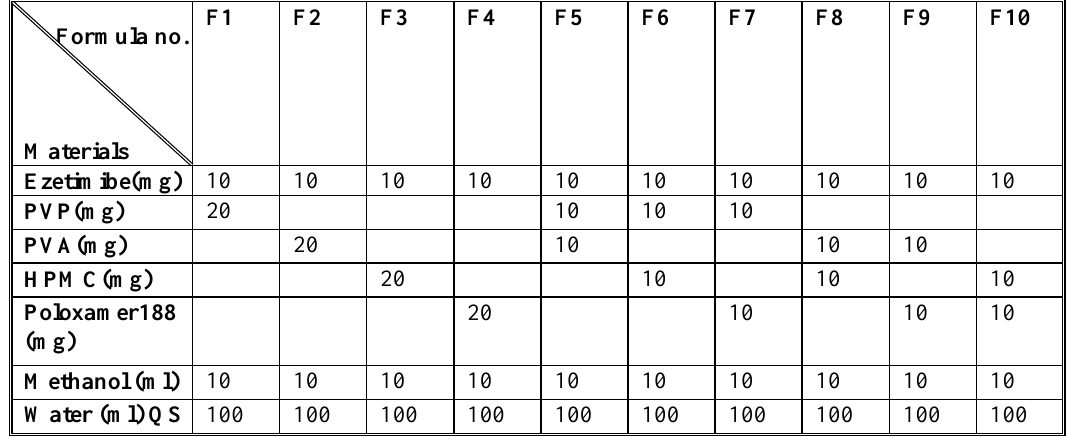
Table (1): Composition of ezetimibe nanosuspension using different types of stabilizers at drug: stabilizer ratio 1:2.